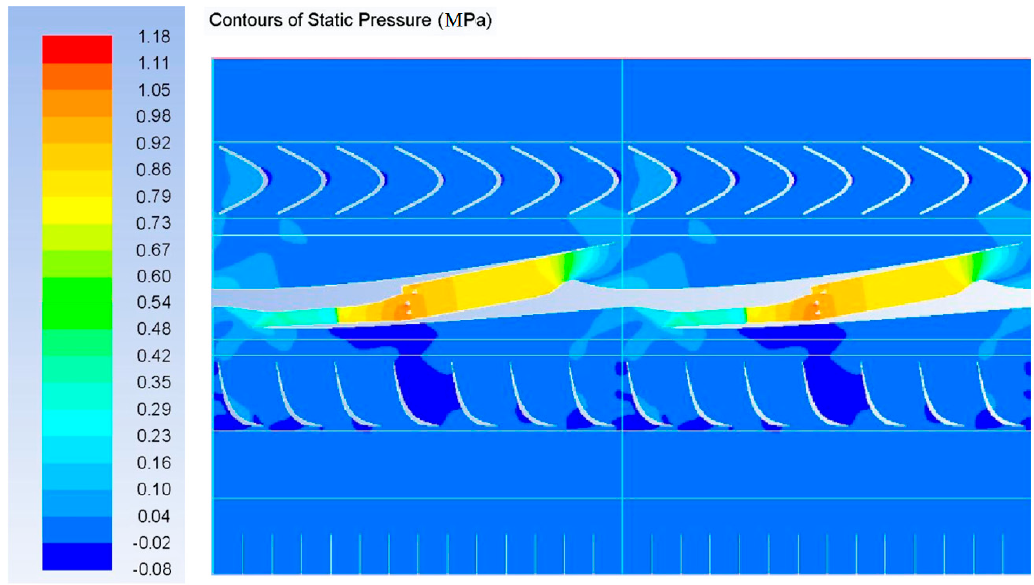
Figure 25. Contours of the pressure distribution inside the engine channels.